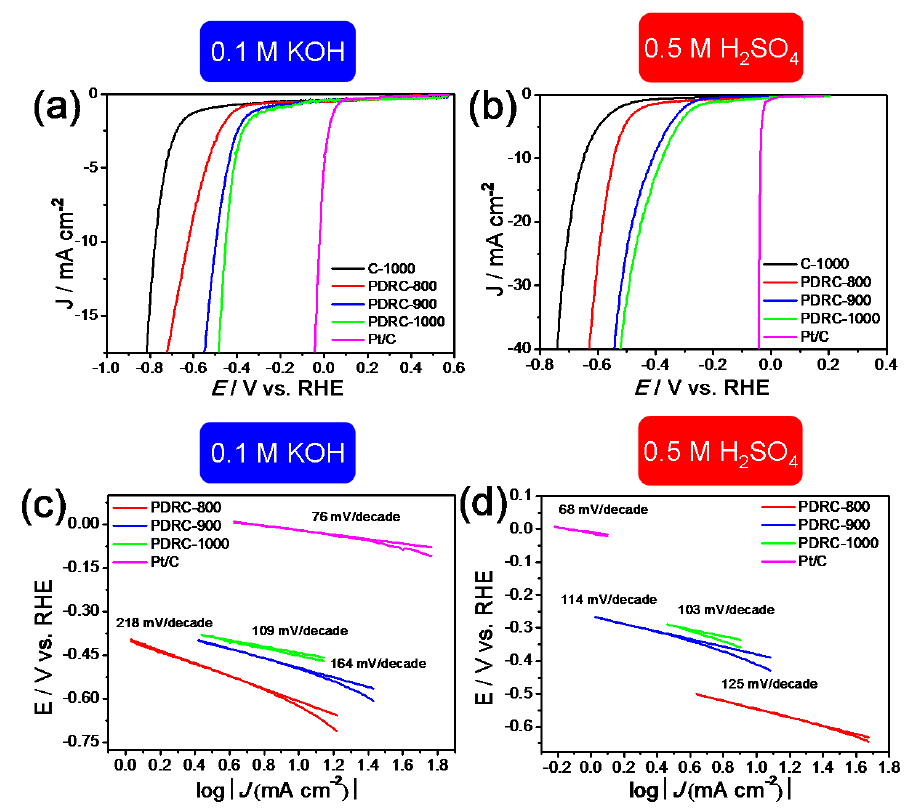
Figure 5. Polarization curves of C-1000, PDRC-800, PDRC-900, PDRC-1000 and Pt / C in ( a ) alkaline and ( b ) acidic media; Tafel plots of PDRC-800, PDRC-900, PDRC-1000 and Pt / C for HER in ( c ) alkaline and ( d ) acidic media, respectively.